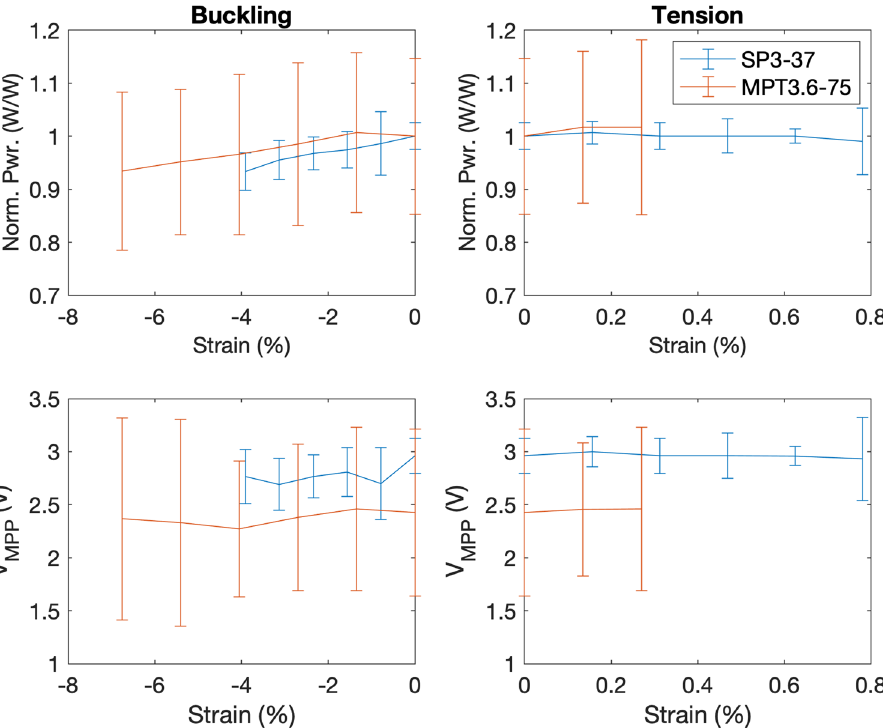
Figure 3. Power generated from panel during buckling (left) and tension (right), normalized to the unstrained output